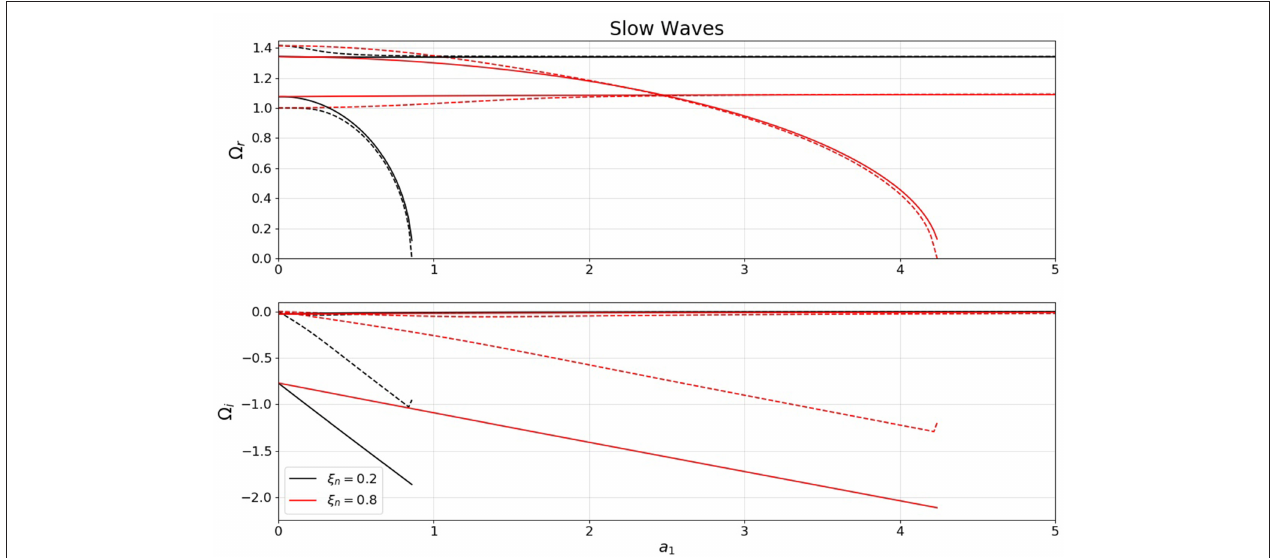
FIGURE 3 | The variation of the real (Upper) and imaginary part (Lower) of the dimensionless frequency, (cid:127) , for Alfvén waves with respect to the dimensionless collisional frequency, a for three different values of the ionization degree of the plasma (color coded). Solid lines represent solutions obtained in the ionization non-equilibrium while dashed line denote the Alfvén waves in ionization